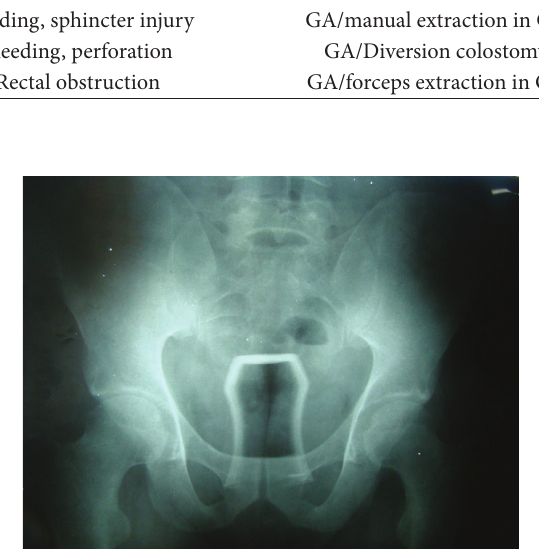
Figure 2: X-rays showed a glass inserted in the rectum.